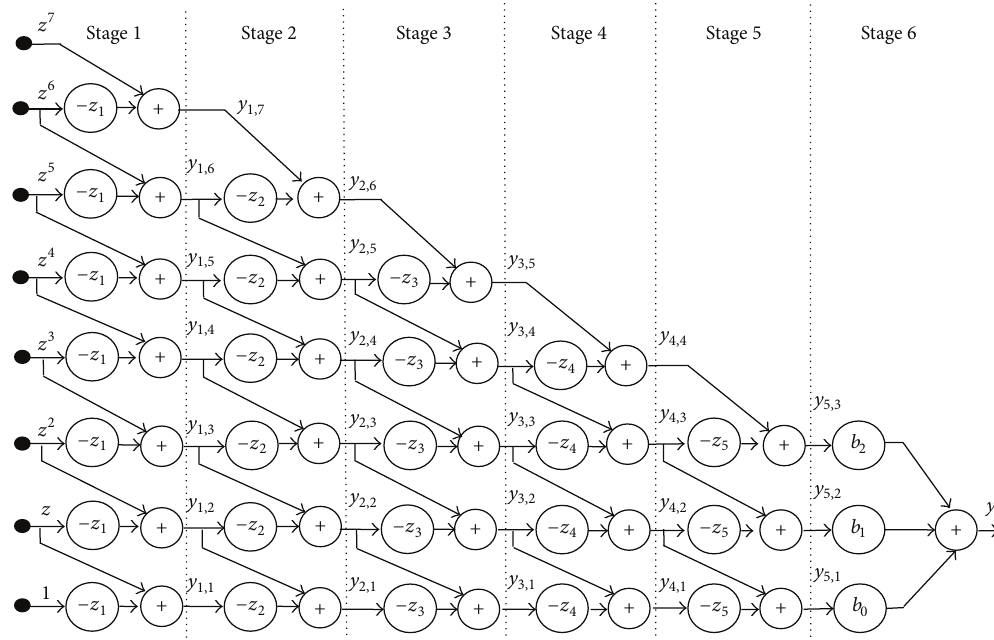
Figure 3: Structure for independent null steering with suppressed